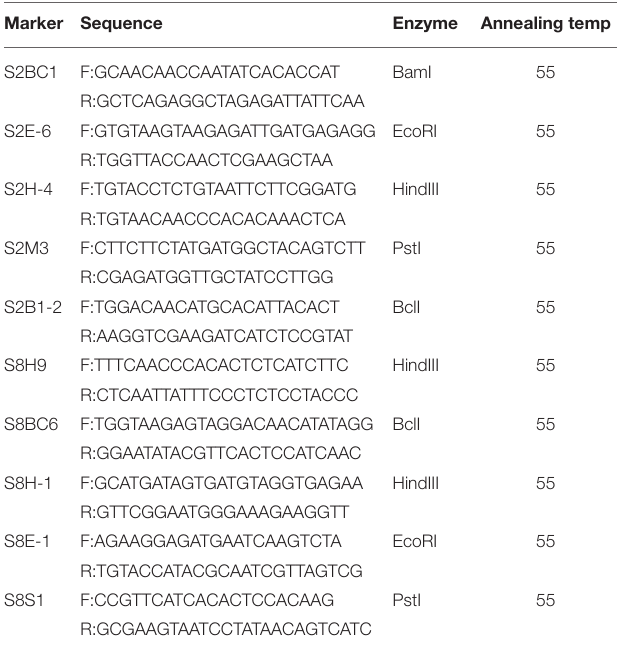
TABLE 3 | Detailed information of the new polymorphic cleaved amplified polymorphism sequence (CAPS) markers within SC2.1 and SC8.1 . Marker Sequence